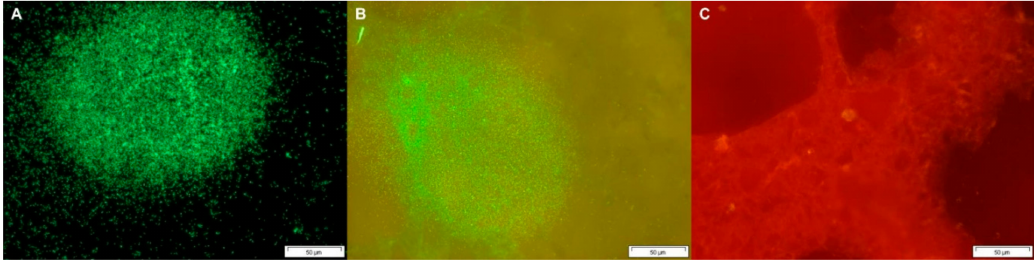
Figure 2. Fluorescence microscopy images of surfaces stained with the Live / Dead ® kit. Live cells in biofilms appeared green in color and dead or injured cell appeared red. ( A ) stainless steel (type 304 grade B finish); ( B ) polyester without biocide, forming biofilms of Listeria monocytogenes after 72 h